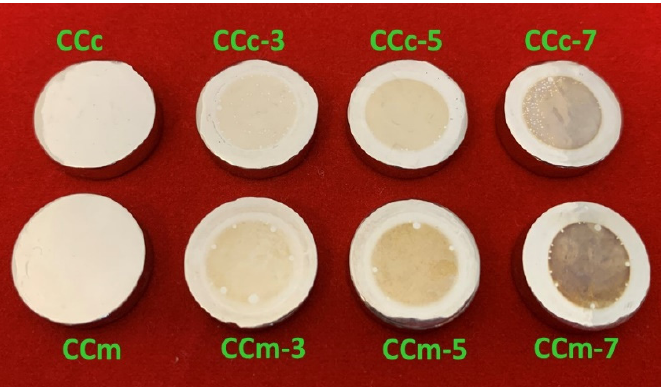
Figure 11. Macroscopic images of the cast and milled Co-Cr alloy after corrosion tests.